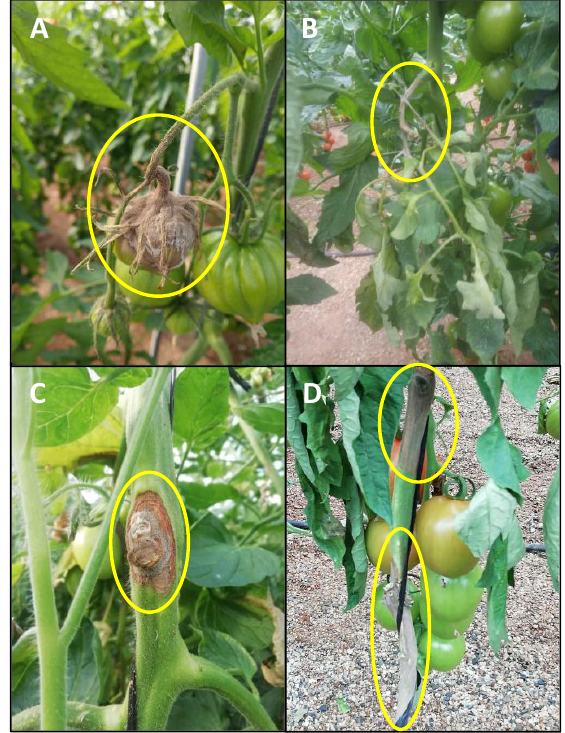
Figure 2. Recorded locations of grey mould symptoms: ( A ) tomato fruits; ( B ) leaves; ( C ) petiole (after pruning in the pictures); ( D ) main stem. Grey mould symptoms highlighted in yellow colour.